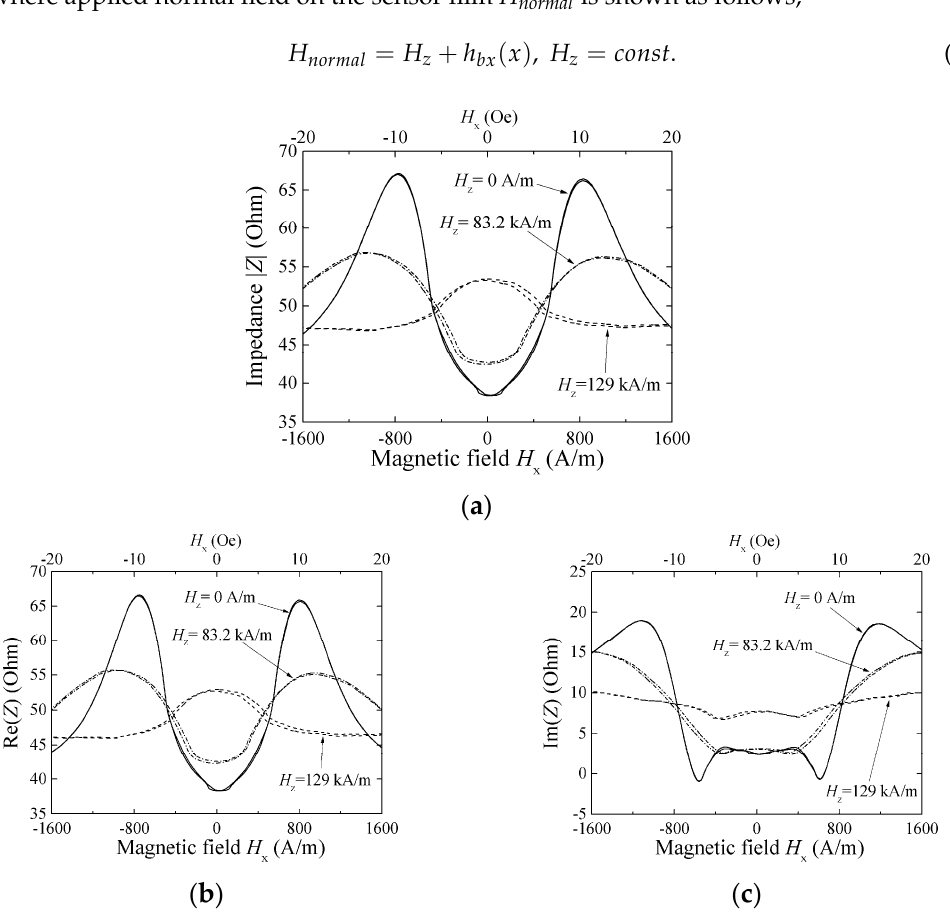
Figure 14. Variation of sensor impedance as a function of external field in X direction. Element dimensions, length: 2000 µ m, width: 50 µ m. Measurement frequency: 500 MHz. ( a ) |Z|, ( b ) Re(Z), and ( c ) Im(Z) [21].